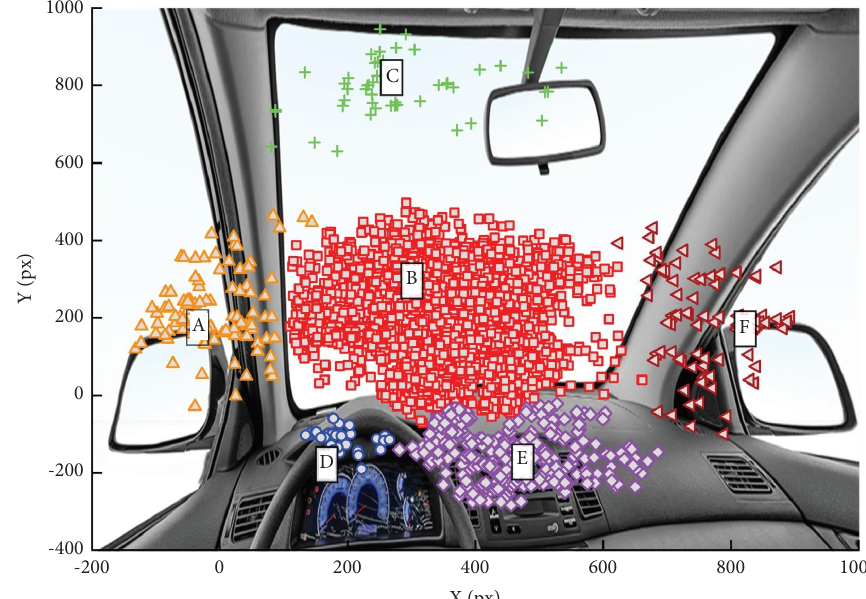
Figure 2: Fixation area division based on hierarchical clustering of fxation points. Te driver’s fxation area is divided into six categories of AOIs.